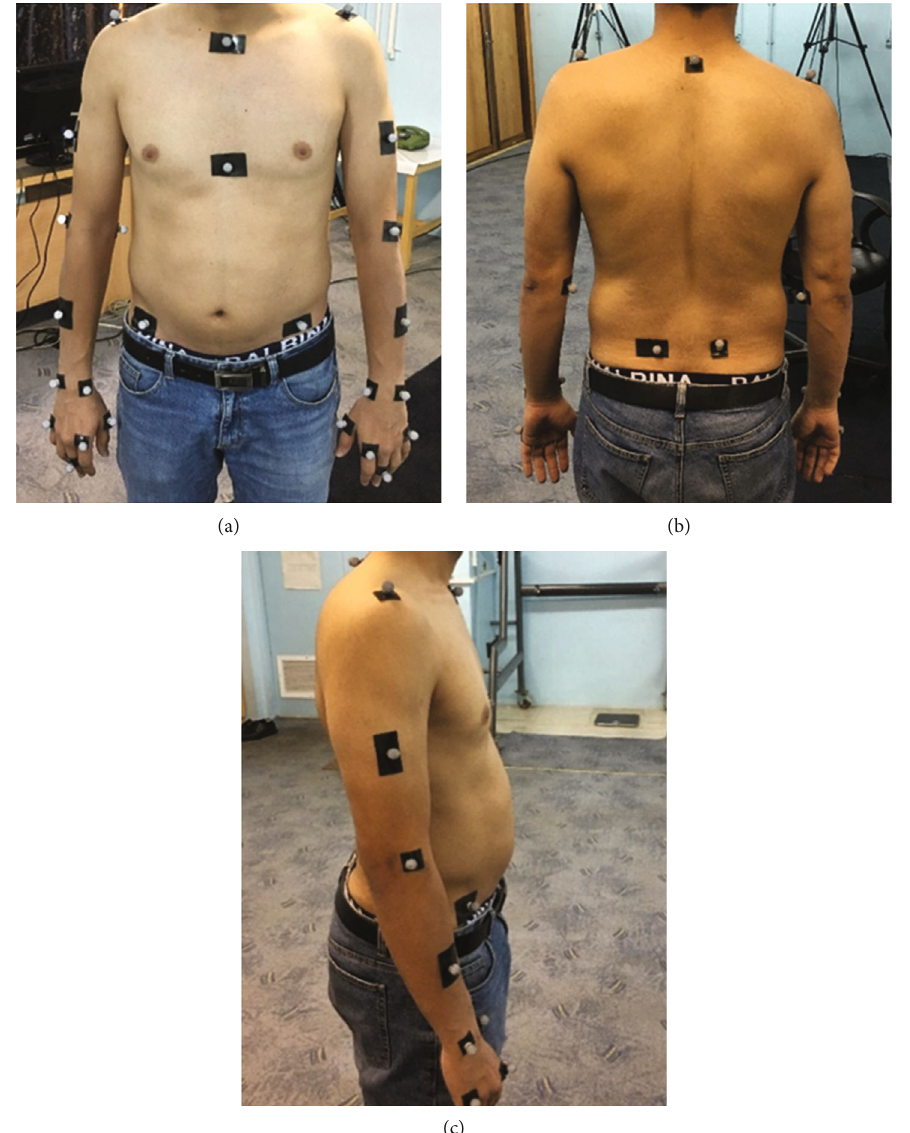
Figure 4: Placement of markers for optical motion capture system. (a) Anterior, (b) posterior, and (c) lateral view. Table 1: Mean ROM ± SD value of fl exion-extension and deviation of the wrists in three distances of the keyboard ( ° ). Variable Right